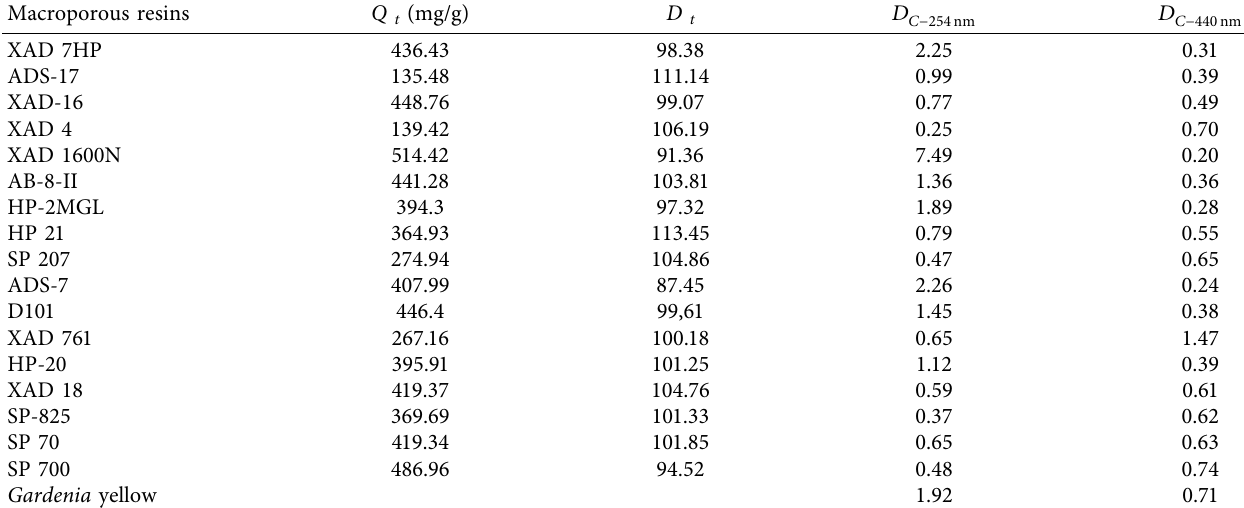
Table 2: Adsorption properties of crocin-I on 17 kinds of macroporous